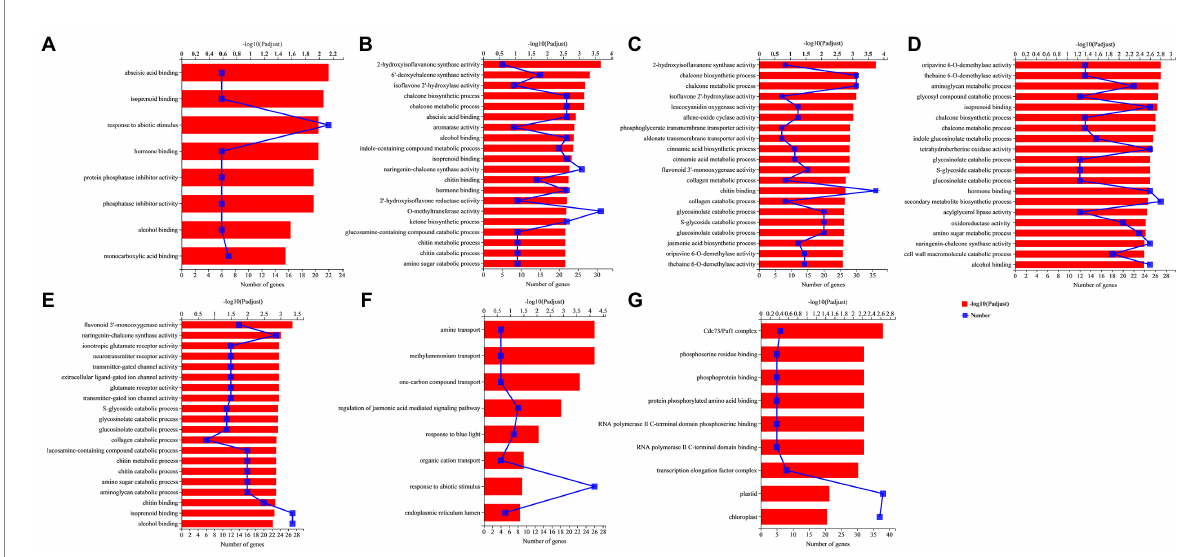
FIGURE 7 GO enrichment analysis in the comparisons (A) NMA − P − vs. NMA+P − , (B) NMA − P − vs. NMA − P+, (C) NMA − P − vs. NMA+P+, (D) AMA − P − vs. AMA − P+, (E) AMA − P − vs. AMA+P+, (F) NMA+P − vs. AMA+P − , and (G) NMA − P+ vs. AMA+P − . The top 20 GO terms are displayed based on differentially expressed genes ( p adjust < 0.05). The upper x -axis shows the significance level of enrichment [ − log 10 ( P adjust )]; the larger the value of − log 10 ( P adjust ), the greater the enrichment. The lower x -axis shows the number of genes. The y -axis shows the GO term. GO, gene